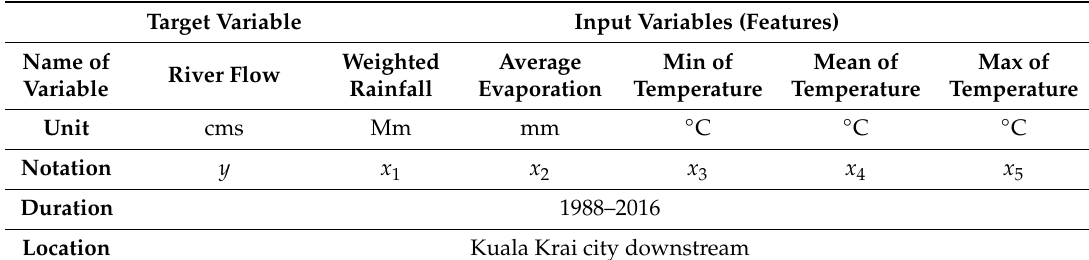
Table 1. Variables and their